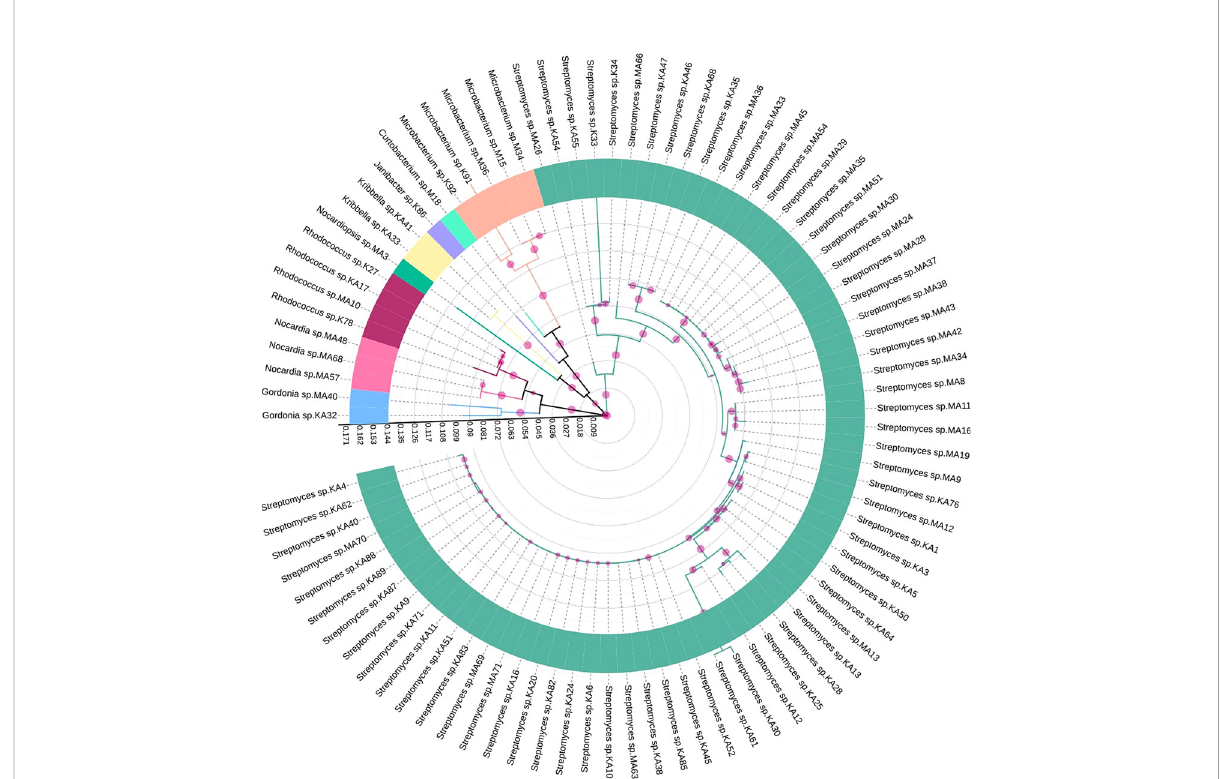
FIGURE 2 Maximum likelihood tree showing genetic diversity of different endophytic actinobacteria isolated from Camellia sinensis based on 16S rRNA gene sequences. Different genera were represented by individual colors. The scale bar represents the phylogenetic distance between taxa and clades. The circles with different sizes represent bootstrap values in respective